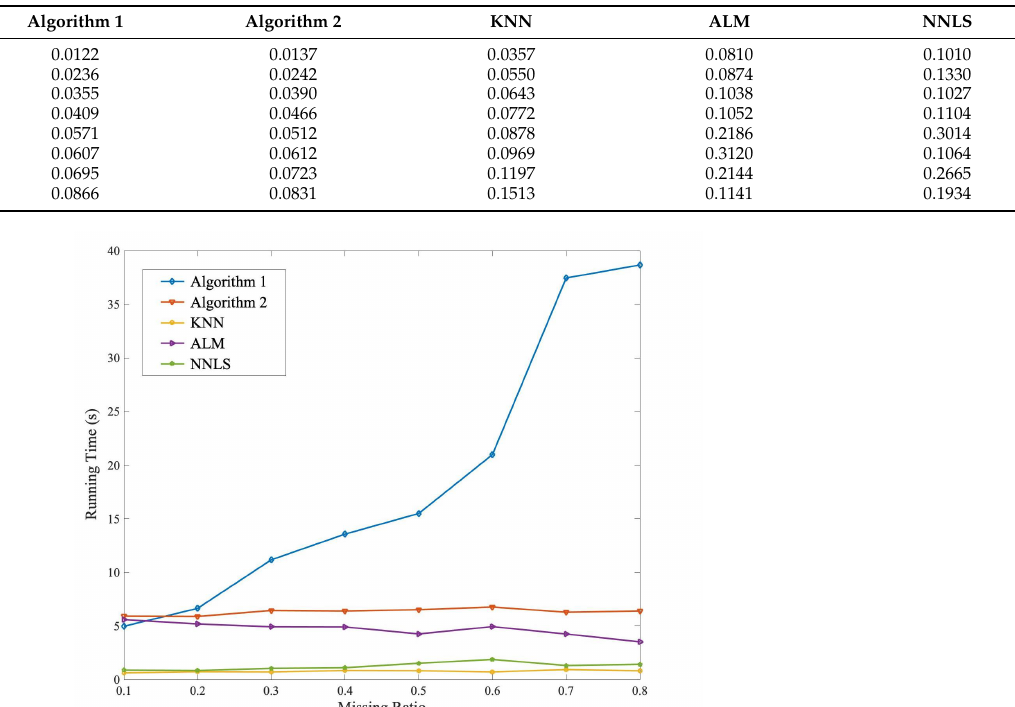
Table 11. The average MSE of five compared methods.